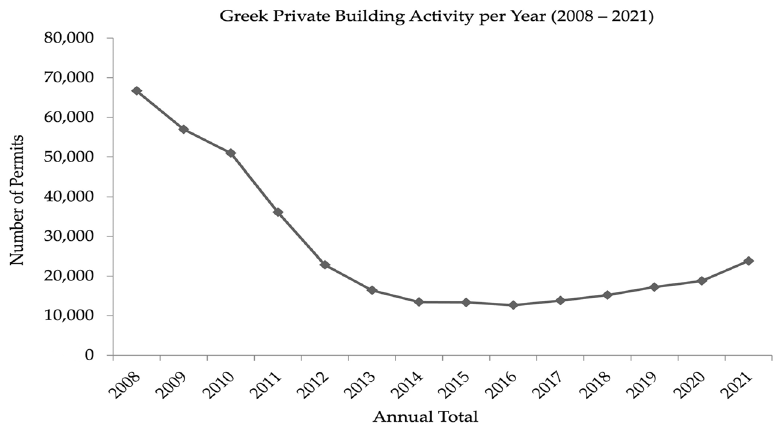
Figure 1. Graphical representation of the annual private building activity.